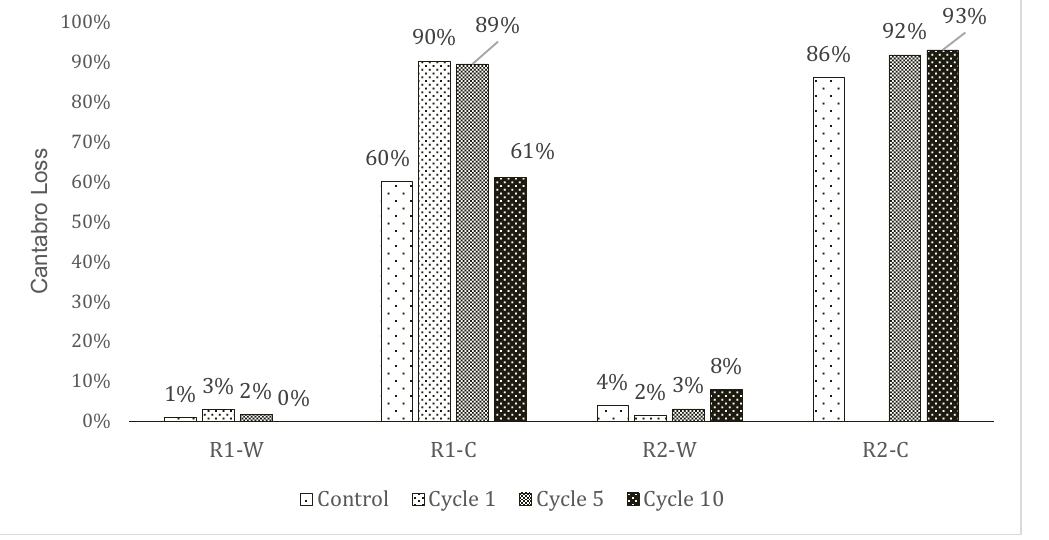
Figure 9. Cantabro loss percentage of the rubberised asphalt specimens at different stages of the F– T procedure.